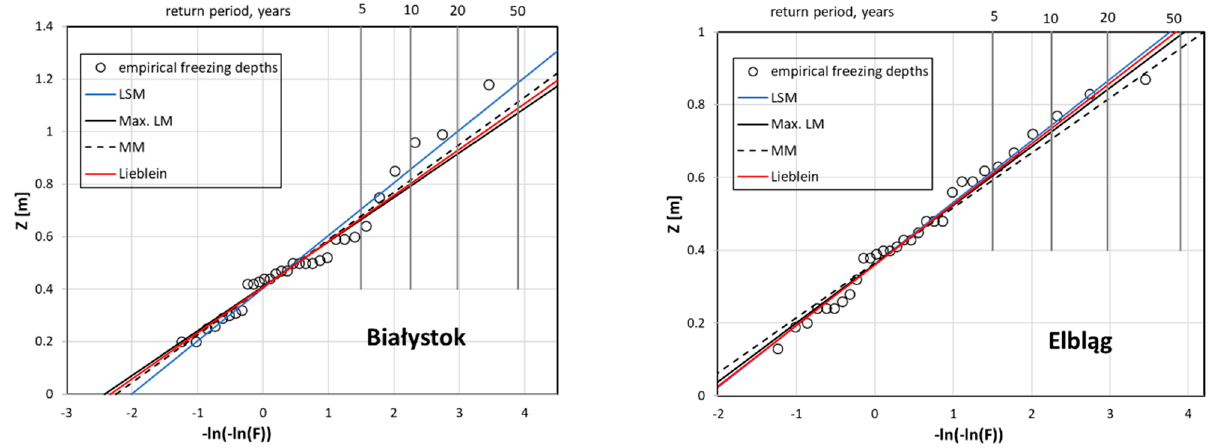
Figure 3. Estimation models for results from Bia ł ystok ( left ) and Elbl ą g ( right ) station—predicted position of zero isotherm for return period.